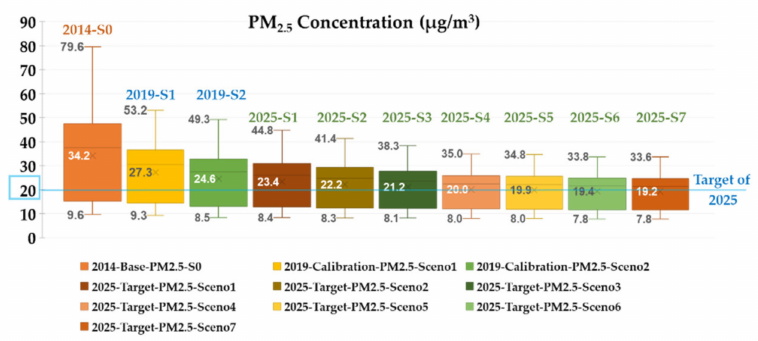
Figure 5. PM 2.5 concentrations in each